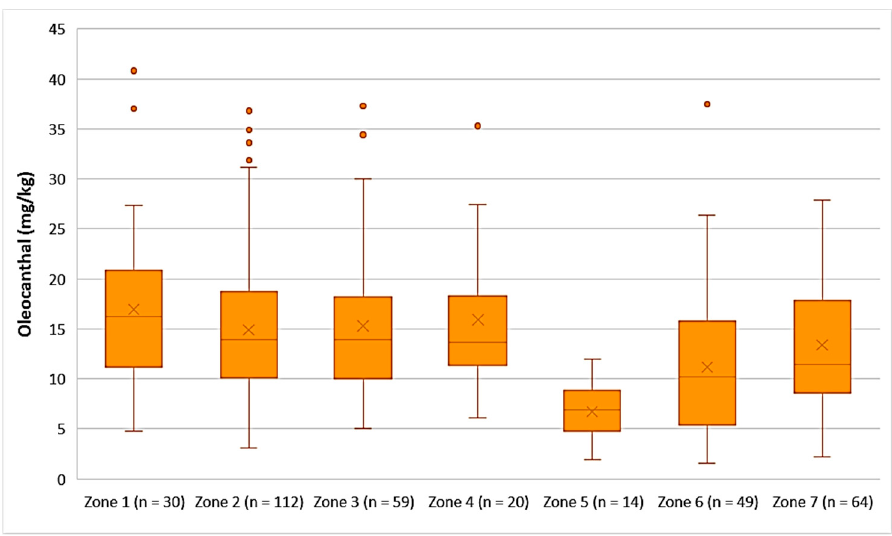
Figure 11. Concentration of oleocanthal (mg/kg) in EVOOs from the seven zones (Zones 1–7) of the island of Lesvos. island of